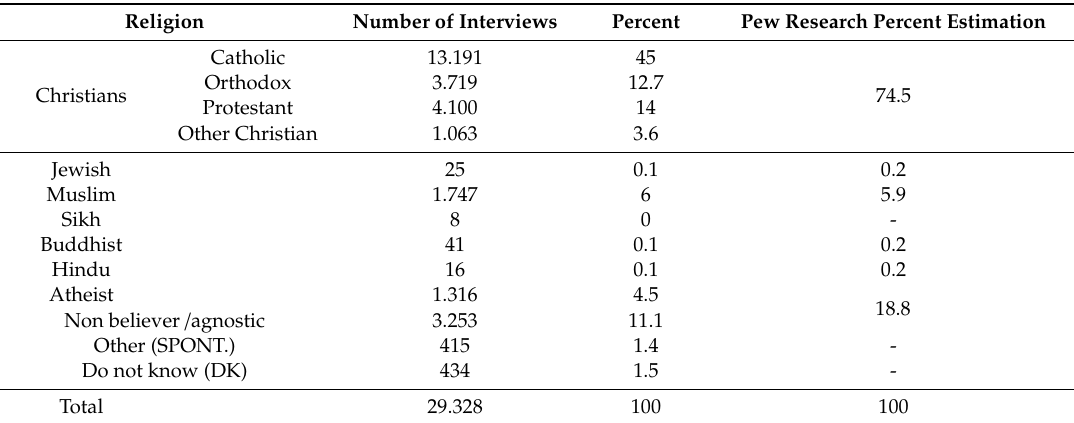
Table 2. Sample representativeness of European